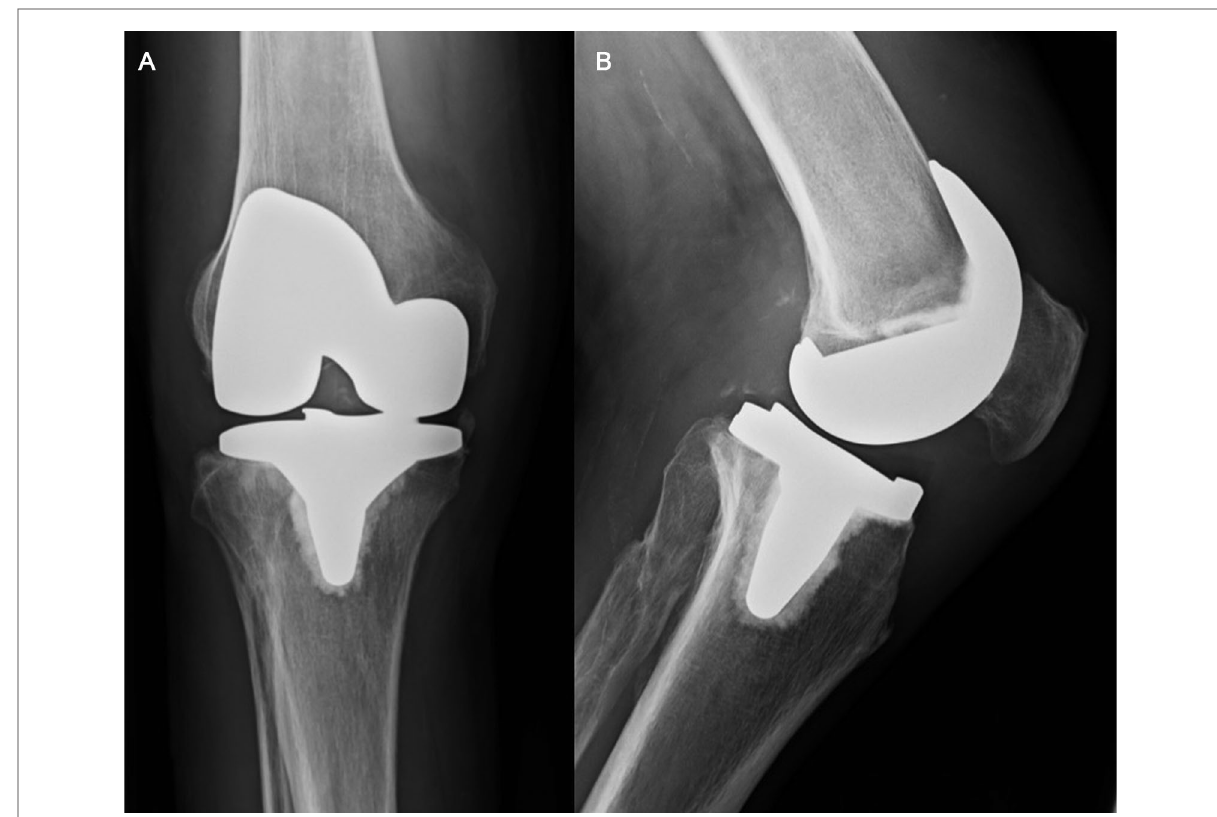
FIGURE 1 ( A,B ) Chronic quadriceps tendon insuf fi ciency. Antero-posterior ( A ) and lateral ( B ) x-ray views of the knee of a patient with a chronic quadriceps tendon insuf fi ciency. The patient sustained a traumatic quadriceps tendon rupture six weeks after primary TKA. Initial attempts of conservative treatment failed and lead to an extension lag of 20°, which was the indication for Marlex mesh reconstruction seven months after primary